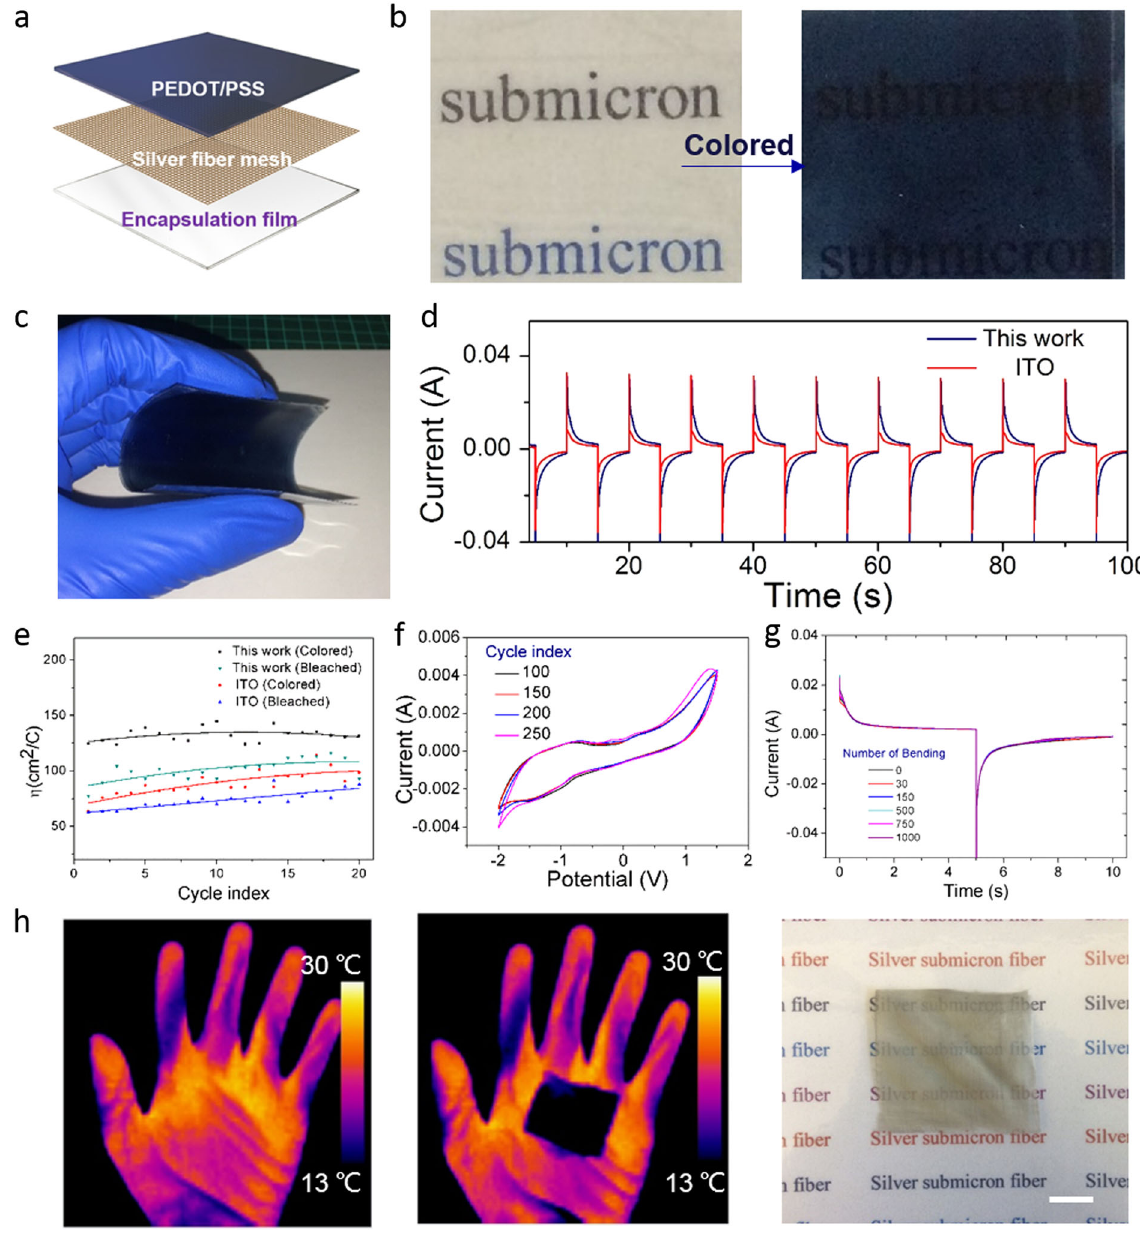
Fig. 4 Pictorial depiction of various applications of silver fi ber mesh. a Structural chart depicting the preparation process of electrochromic smart window. b Images of before and after being colored. c Flexibility for the fi lms after being colored. d I – t curve corresponding to the sample obtained in this work and ITO. e The electrochromic ef fi ciency of colored and bleached samples obtained from this work shows better than ITO. f Cyclic voltammetric curve of different cycles (100, 150, 200, 250). g Stability test of the electrochromic smart window after being subjected to bending for up to 1000 times. h Pictorial representation of infrared stealth thin fi lm based on silver fi ber mesh (scale bar: 1 times. Supplementary Figure S6 represents the stability test of silver submicron fi bers/PET substrate in acidic and alkaline conditions, which in turn indicates good resistance stability of silver fi ber mesh/PET substrate under acidic or alkaline environment. At present, ITO as a relatively mature material of transparent electrode, displays relatively excellent photoelectric properties, and is widely used in the industry. However, the large brittleness